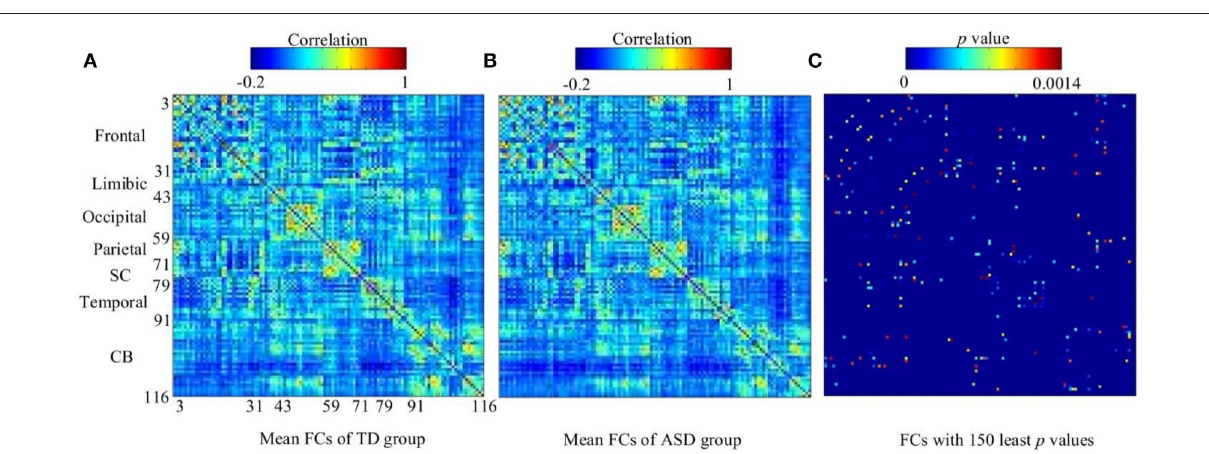
FIGURE 8 | The visualization of group FCs. (A) Mean FCs of TD group ( − 0.2 ≤ r ≤ 1). (B) Mean FCs of ASD group ( − 0.2 ≤ r ≤ 1). (C) Group differences in the 150 FC patterns (evaluated by a two sample t -test with a threshold of p < 0.0014). Both x and y axes of each subfigure indicate areas in AAL atlas (SC, subcortical area, CB,